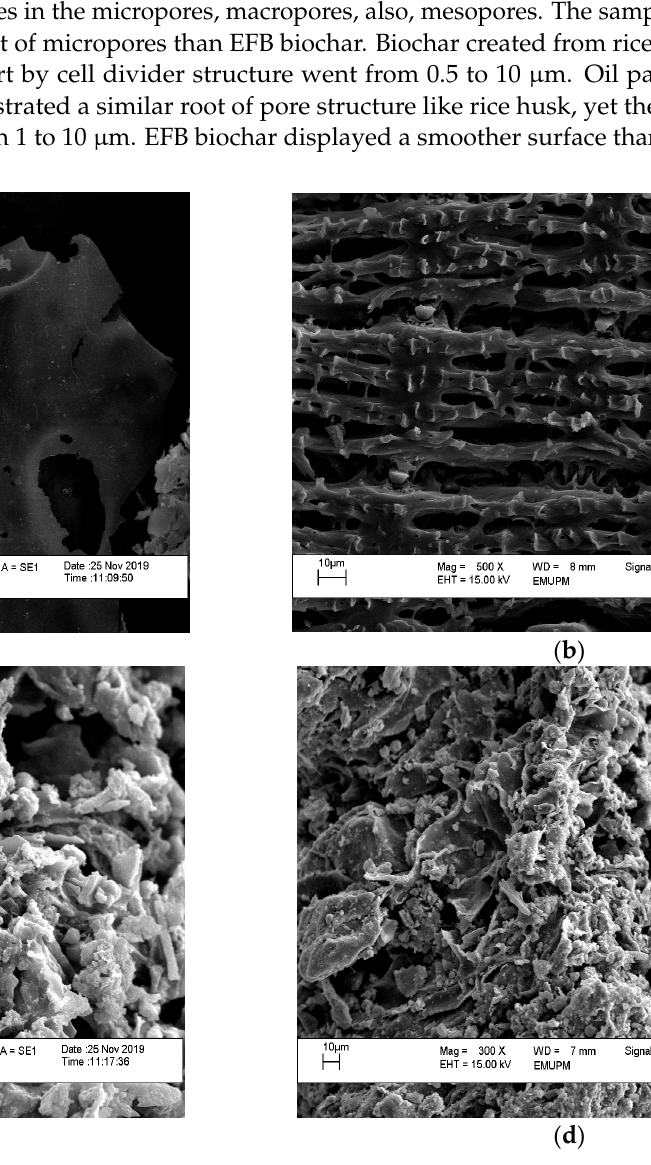
Figure 1. The micrograph by scanning electron microscopy (SEM) for the RHB ( a , b ) at 1K× and 500×, and EFBB ( c , d ) at 1K× and 300× magnifications. Mag: Magnification, WD: Working distance, SE1: Secondary electron, EHT: Electron high tension, EMUPM: Electron microscopy Universiti Putra Malaysia.